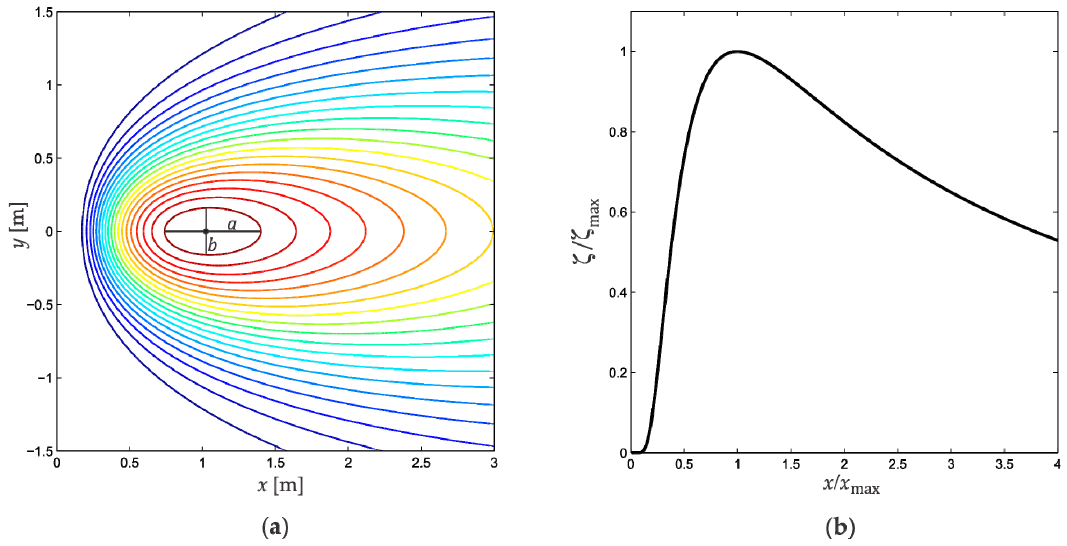
Figure 1. Gas source theoretical distribution: ( a ) Isoconcentration lines obtained by evaluation of Equation (5). The ovoid shape of the lines is determined by the wind, with the semi-major axis a aligned to the wind direction and with the semi-minor axis b aligned to cross-wind; ( b ) Normalized Gaussian concentration profile using Equation (6).